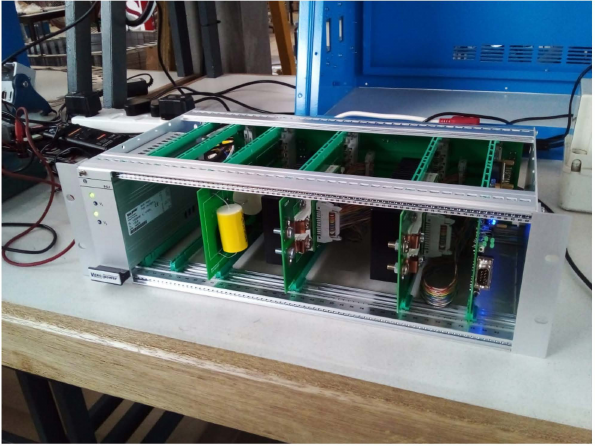
Figure 11. The configurable perturbation source used as both a PRBS and PRIS source.